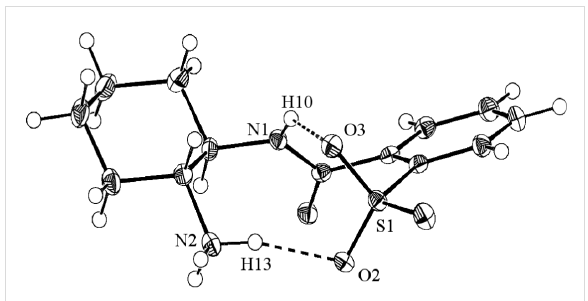
Figure 1: X-ray crystallographic structure of 5 . The conformation of the 2-sulfobenzoic moiety is fixed by hydrogen bonds. The distance H10 … O3 is 2.283 Å, the distance H13 … O2 is 1.920 Å. (distance N1-O3: 2.865 Å, distance N2-O2: 2.822 Å, ellipsoids: 50%